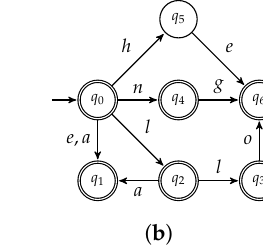
Figure 7. ( a ) A , L ( A ) = { lang , hello } ( b ) A (cid:48) = SS (cid:93) ( A ,2, (cid:62) Const )